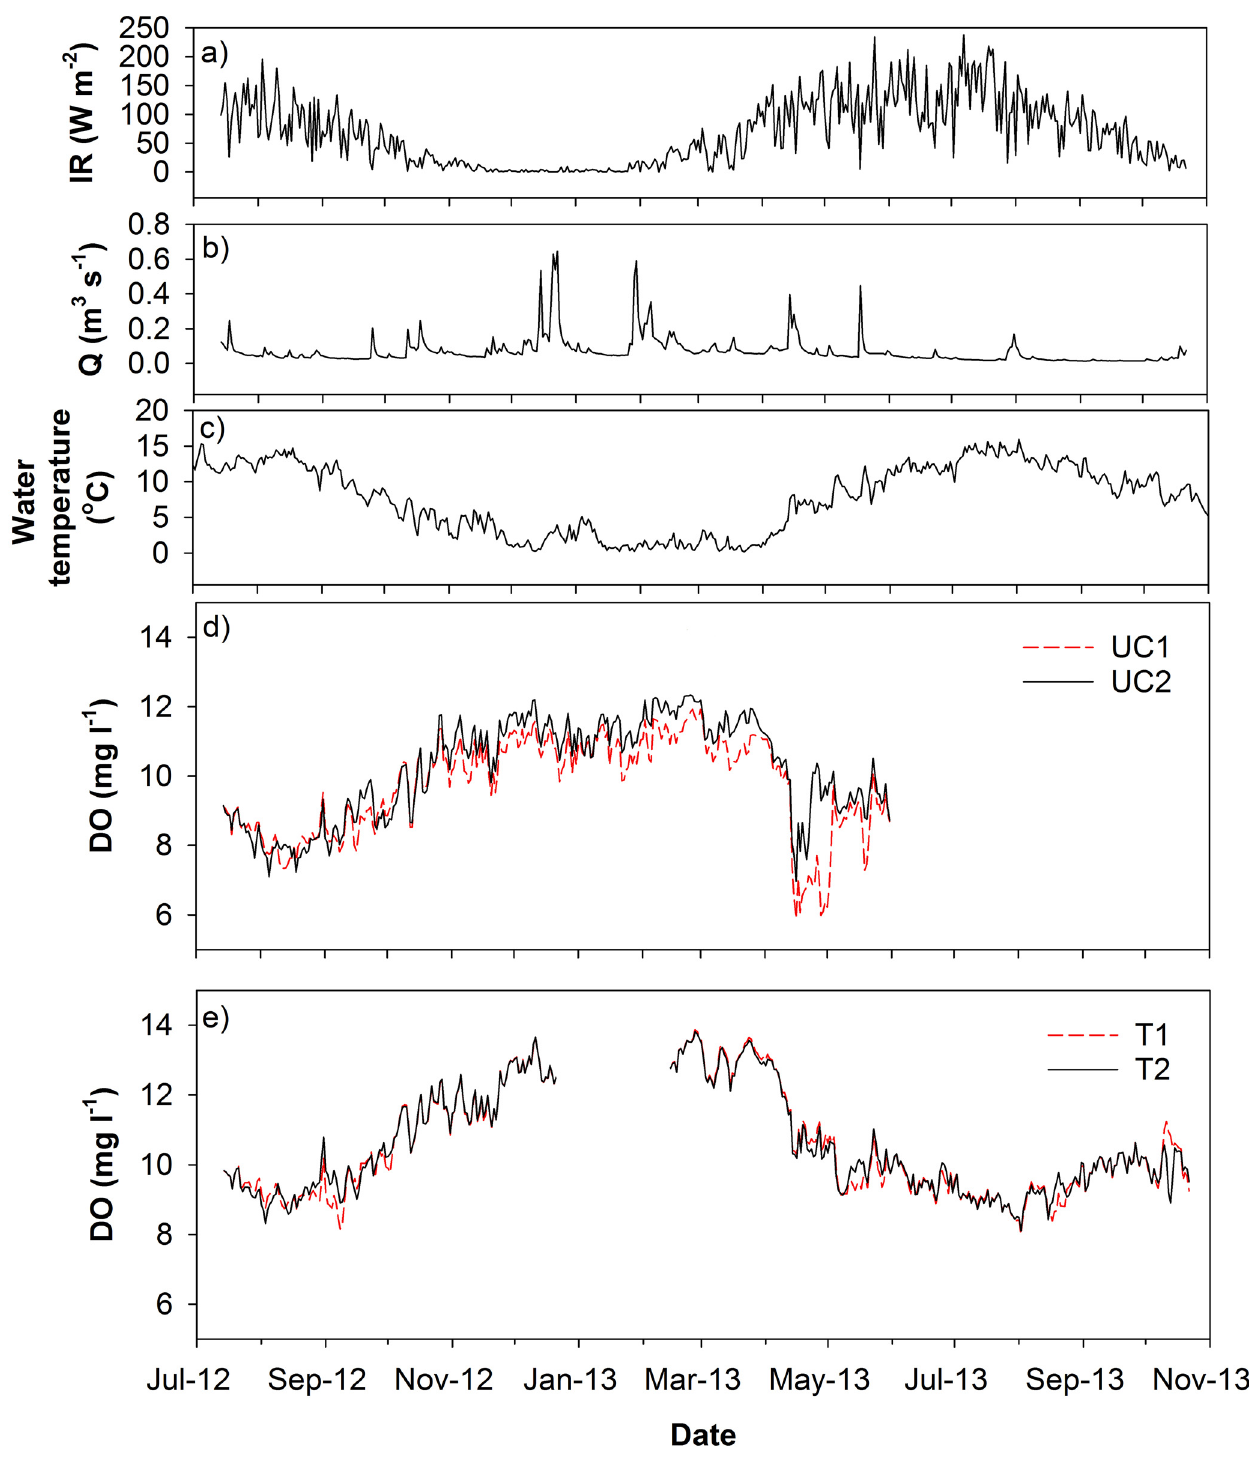
Fig 2. Mean Daily plots of: a) incoming shortwave radiation (IR), b) discharge (Q), c) water temperature at both sites, and dissolved oxygen for both the upper catchment (UC), panel d and the lower catchment (LC), panel e.